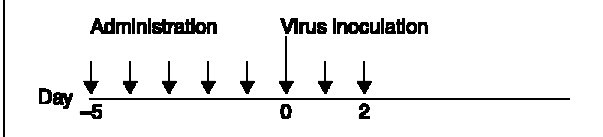
FIG. 1. Protocol of Sendai virus-challenge